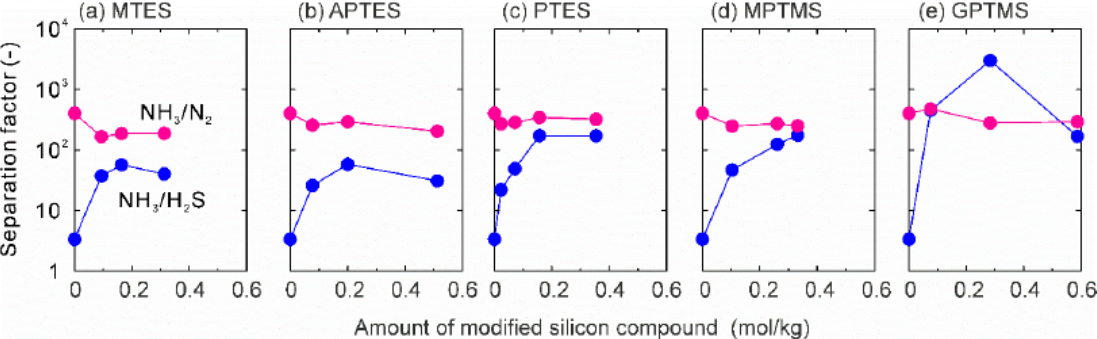
Figure 9. Influence of modification with silicon compounds on the separation factors of FAU-type zeolite membranes for ternary mixtures of NH 3 , H 2 S, and N 2 at 295 K. ( a ) MTES, ( b ) APTES, ( c ) PTES, ( d ) MPTMS, and ( e )